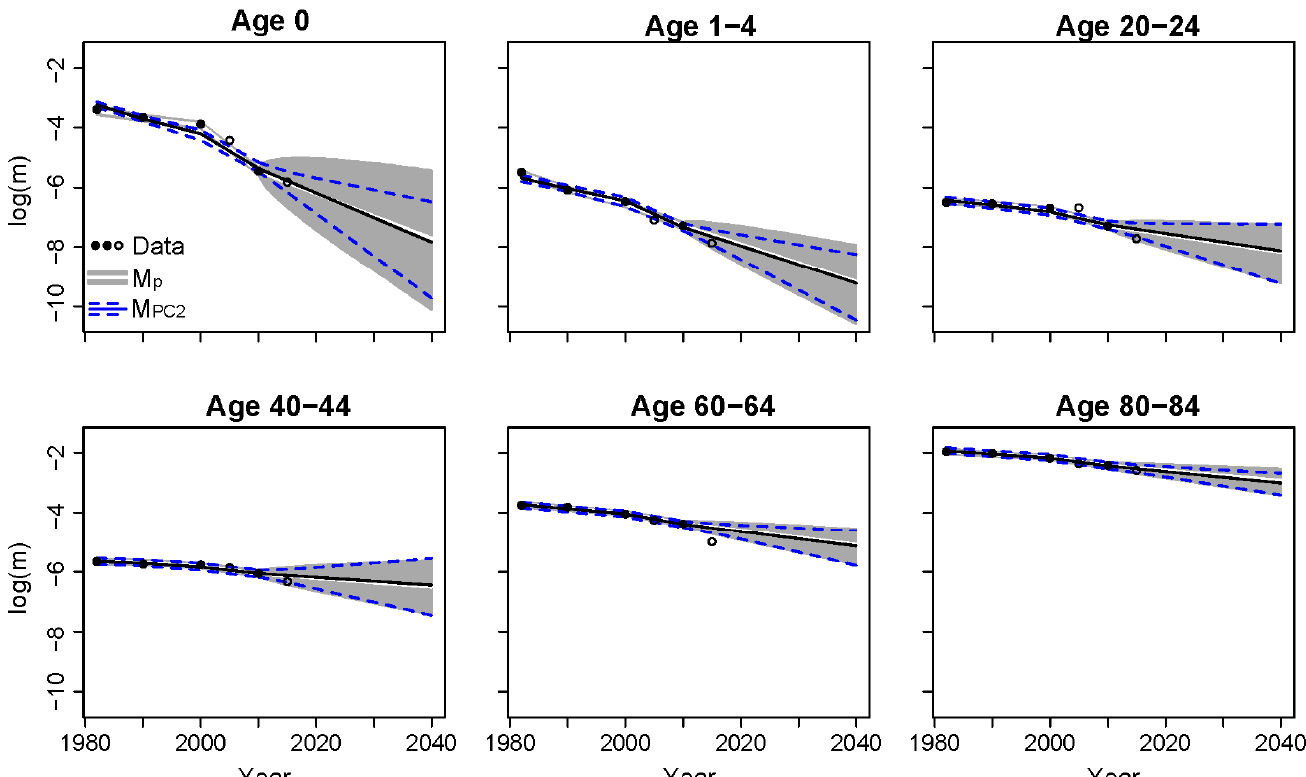
Figure 9. Estimates and forecasts of M PC2 and M p for China.